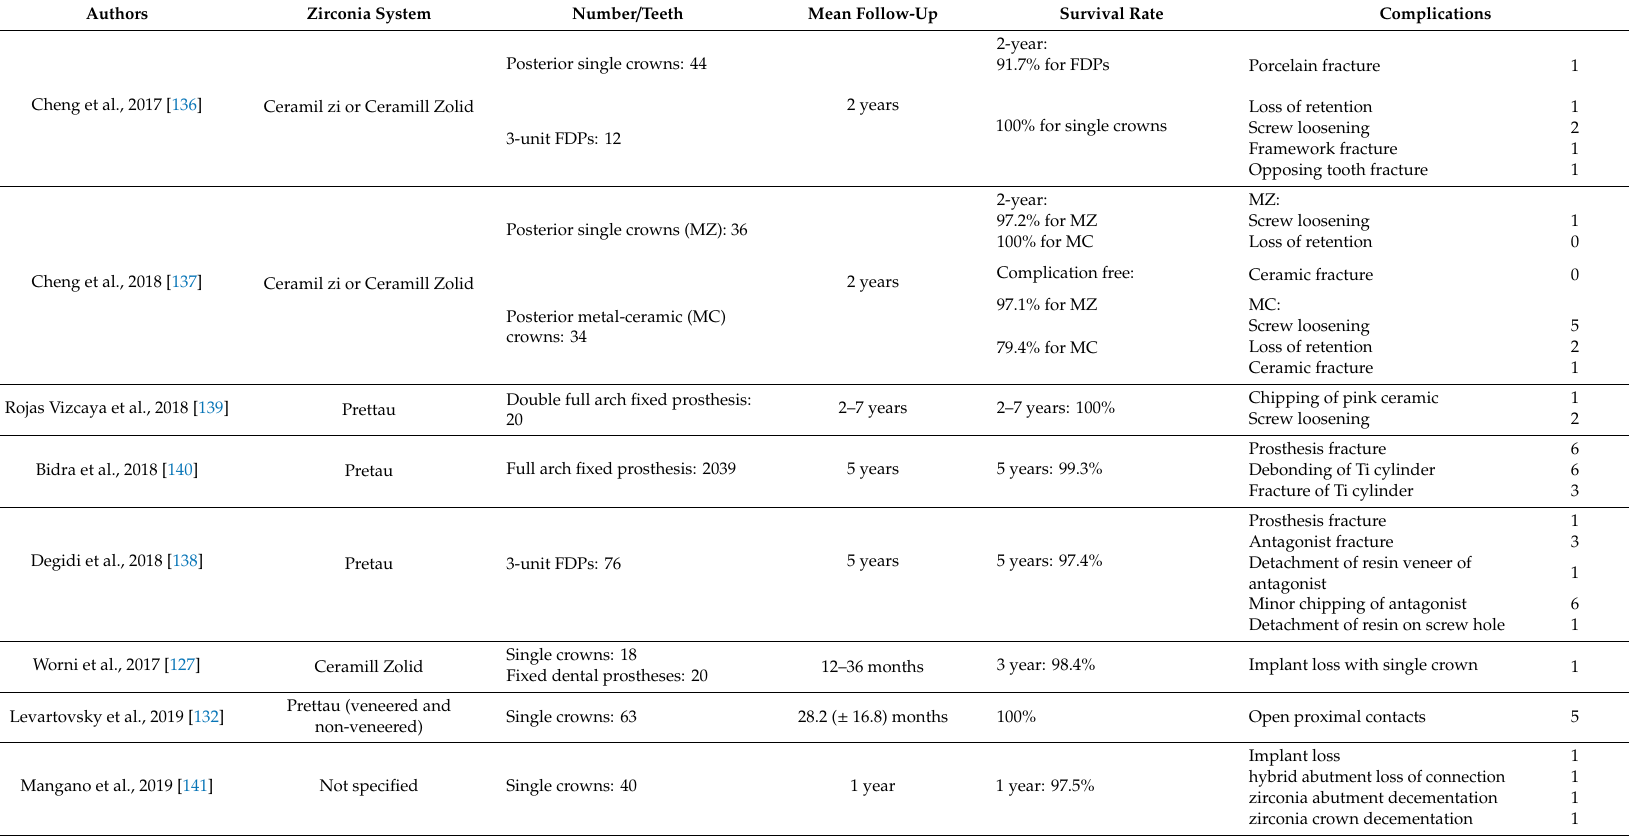
Table 3. Clinical studies with monolithic zirconia restorations on